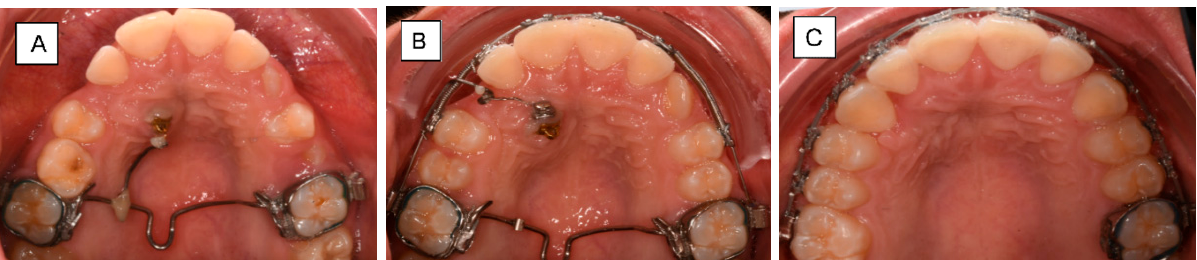
Figure 6. Traction of a palatally impacted right maxillary canine. ( A ) Canine extrusion with 0.017 × 0.025 ″ TMA cantilever inserted into the welded sheet on TPA, activated for extrusion. ( B ) Cantilever placed into the auxiliary tube of an upper molar, activated for canine extrusion and buccal displace- ment. ( C ) The canine is aligned into its final position.